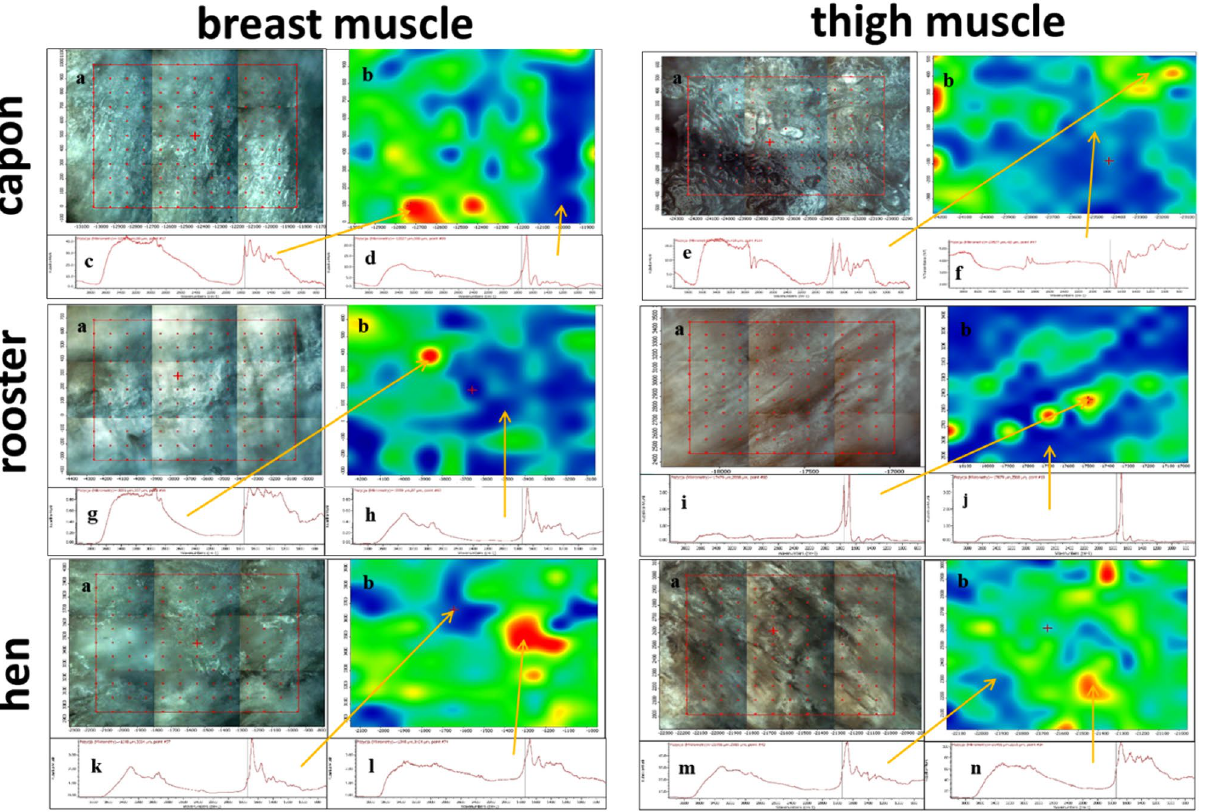
Figure 1. Microscopic image, chemical maps and FTIR spectra of the studied muscles. ( a ) Microscopic image with mapped area, ( b ) chemical map, ( c ) FTIR spectrum determined at 12,787 µm, 98 µm from the red area, ( d ) FTIR spectrum determined at 12,027 µm, 89 µm from the red area, ( e ) FTIR spectrum determined at position 23,327 µm, 418 µm from the red area, ( f ) FTIR spectrum determined at position 23,327 µm, 47 µm from the red area, ( g ) FTIR spectrum determined at position 3859 µm, 387 µm from the red area, ( h ) FTIR spectrum determined at position 3559 µm, 87 µm from the blue area, i) FTIR spectrum determined at position 17,479 µm, 2968 µm from the red area, ( j ) FTIR spectrum determined at position 17,679 µm, 2568 µm from the blue area, ( k ) FTIR spectrum determined at position 1648 µm, 3664 µm from the blue area, ( l ) FTIR spectrum determined at position 1348 µm, 3464 µm from the red area; ( m ) FTIR spectrum determined at position 21,956 µm, 2315 µm from the blue region, ( n ) FTIR spectrum determined at position 21,456 µm, 2215 µm from the red